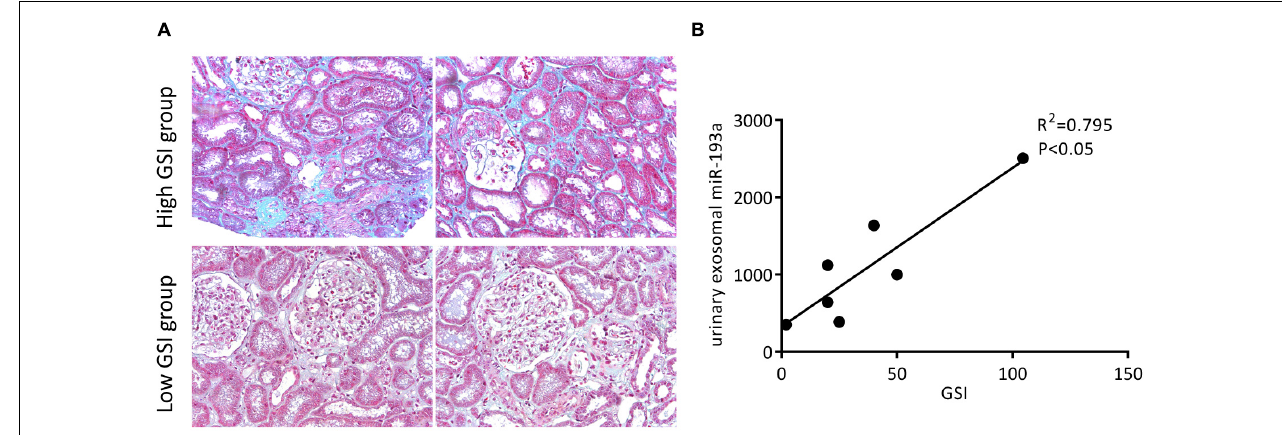
FIGURE 4 | Prognostic values of urine exosomal miR-193a levels in patients with primary FSGS. (A) Representative photomicrographs of the renal biopsy with Masson’s trichrome staining (200 × ). (B) The correlation between the expression level of urine exosomal miR-193a with GSI in patients with primary FSGS.